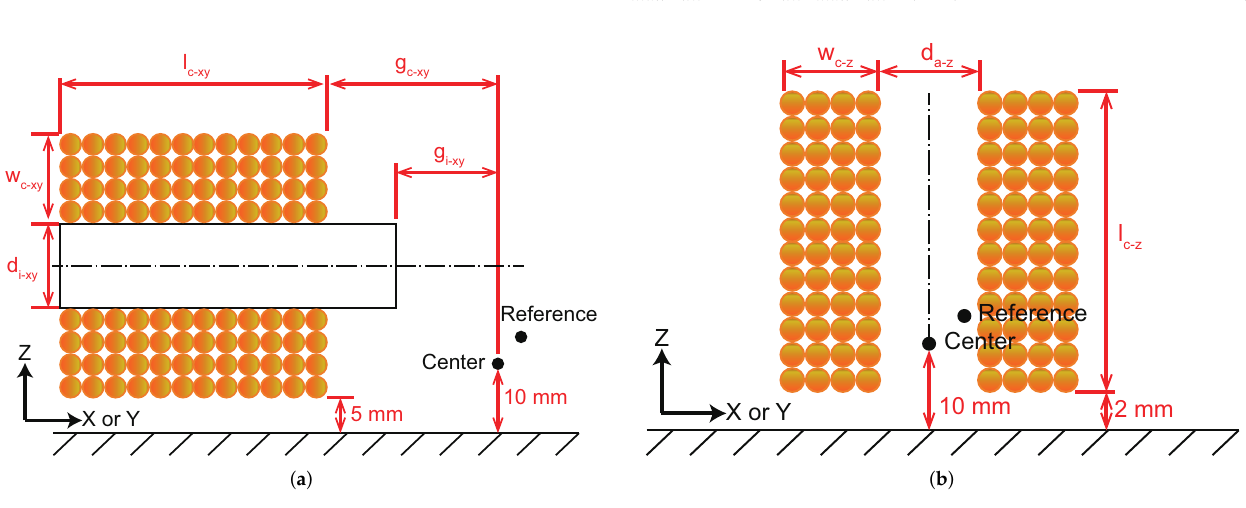
Figure 3. Main geometric parameters of the coils ( a ) along x-axis or y-axis, and ( b ) along